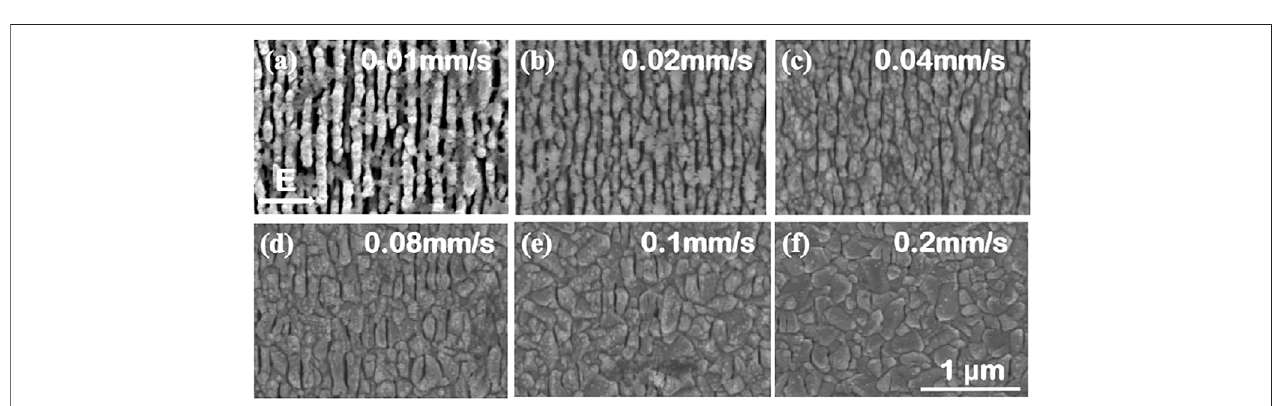
FIGURE 6 | SEM images of FTO thin fi lms irradiated by a 515 nm fs laser at different scanning speeds. The laser fl uence is 23 mJ/cm 2 .